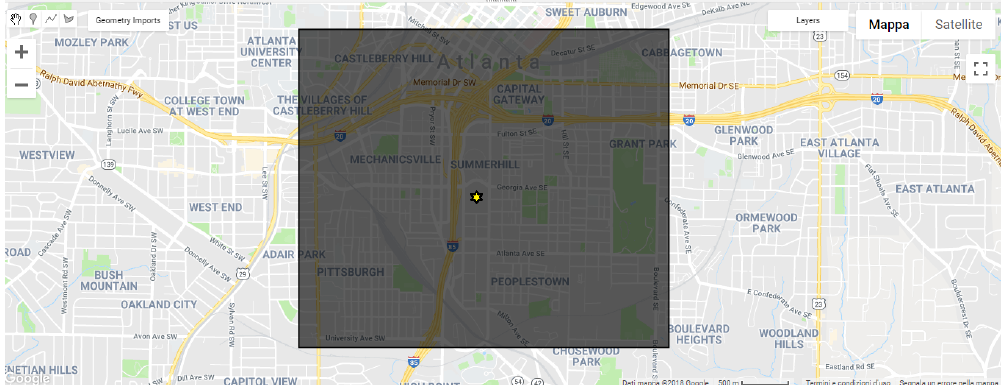
Figure 8. The ROI around the Georgia State University weatherSTEM station, Peoplestown (GA), considered for the LST vs. air temperature comparison (the star denotes the location of the permanent weather station).